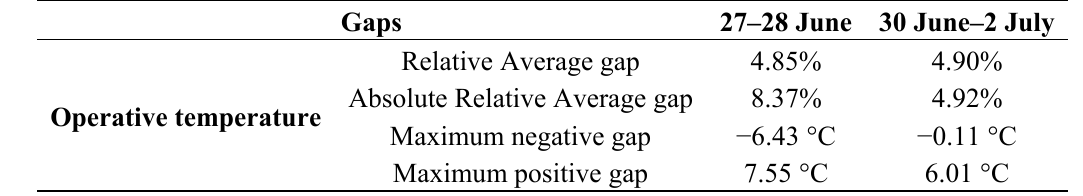
Table 2. Comparison between measured and calculated operative temperature of PV-PCM